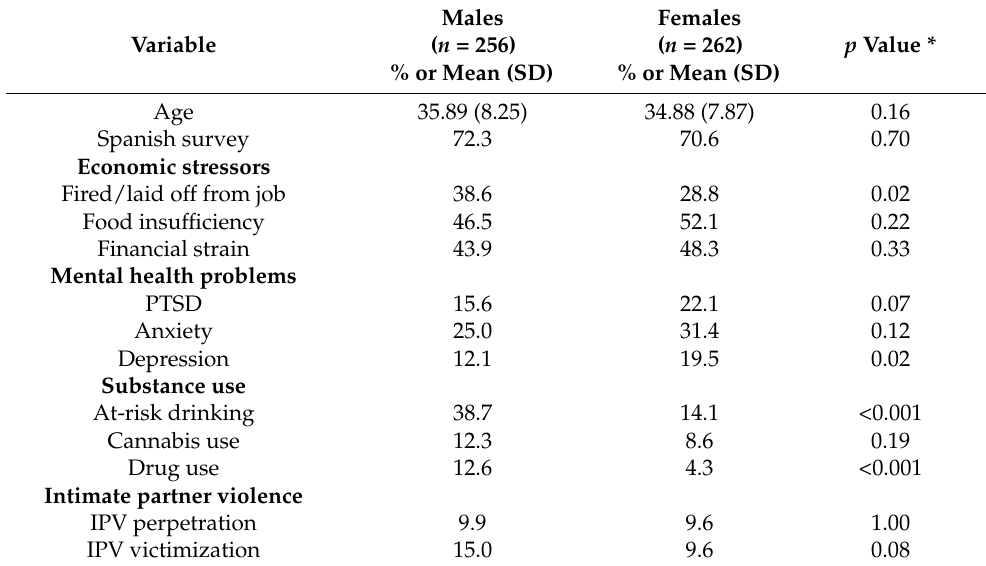
Table 1. Sample Characteristics.